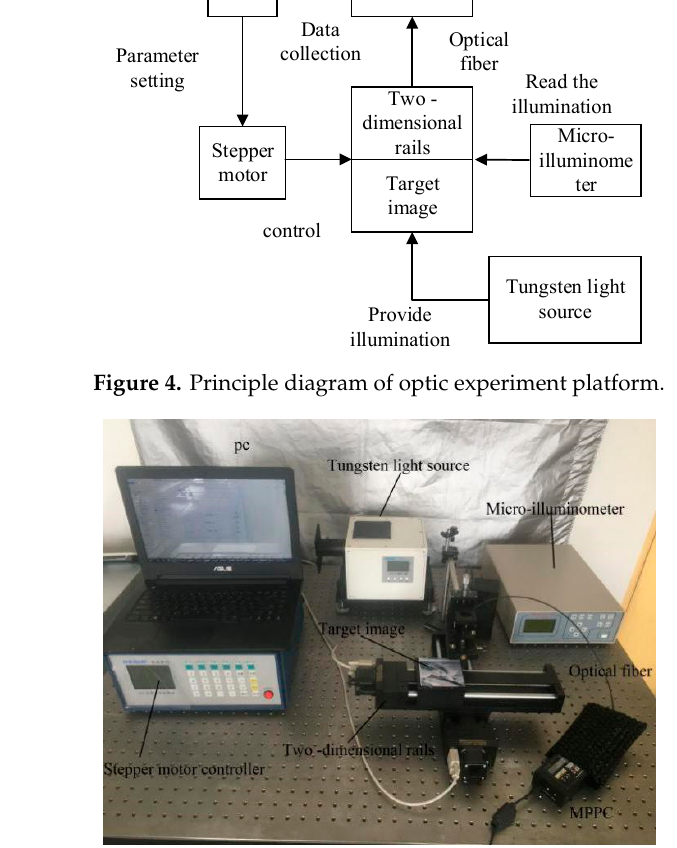
Figure 5. Image of real optic experiment platform.